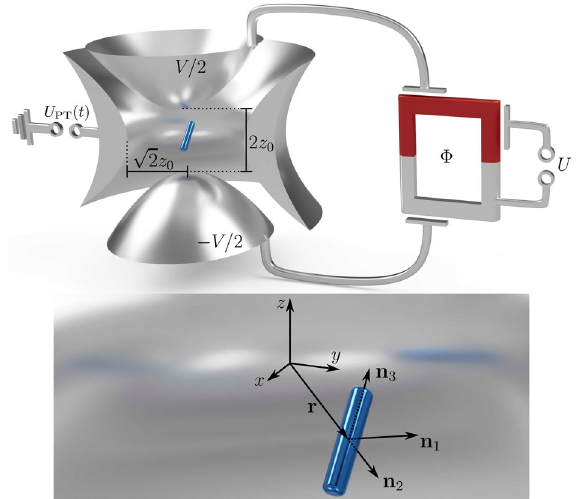
Fig. 1 Proposed setup. The rotational and translational motion of a charged nanoparticle (blue) levitated in a Paul trap induces an electrical current between the superconducting endcap electrodes. The latter can be coherently interfaced with a charge qubit formed by a superconducting island (red). This Cooper-pair box can be used to generate and read-out spatial superpositions of the nanoparticle. The system constitutes the basic element for networking levitated nanoparticles into hybrid quantum devices based on superconduct- ing